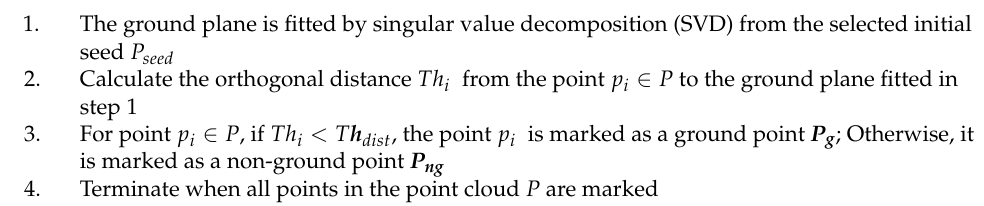
Table 2. Ground point extraction